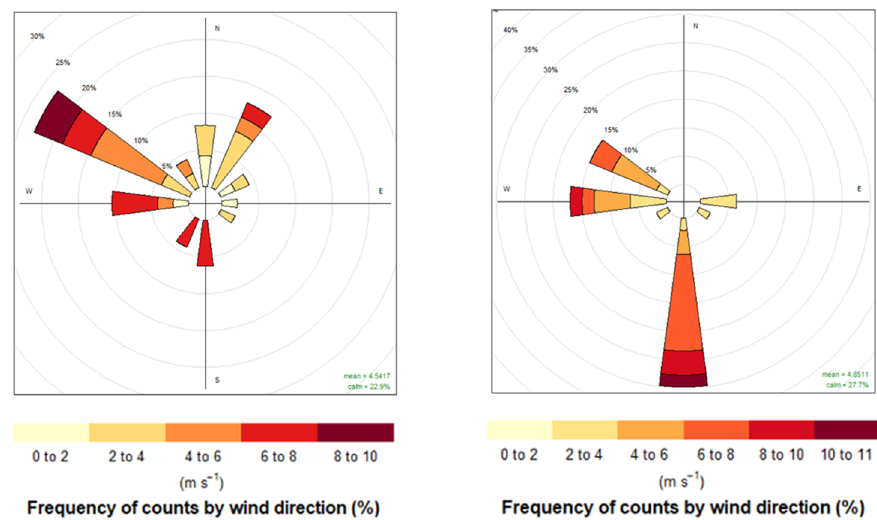
Figure 4. The wind speed and direction and the frequency of counts by wind direction on 12–13 July 2017.